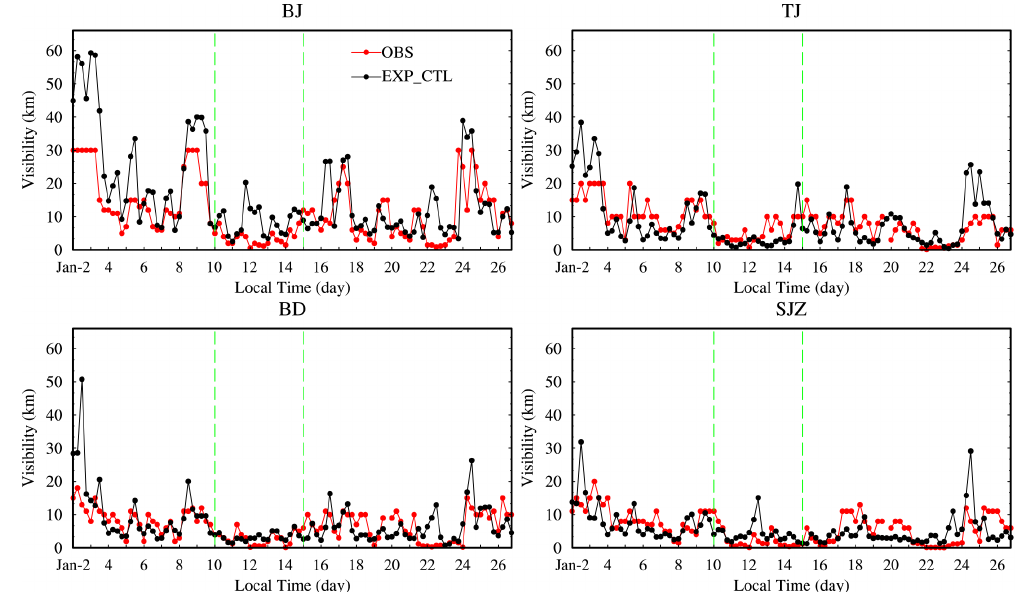
Figure 4. Time series of hourly visibility (km) at 00:00, 06:00, 12:00, and 18:00 from CNMC measurements and the corresponding WRF- Chem simulation (EXP_CTL) at BJ, TJ, BD, and SJZ during 2–26 January